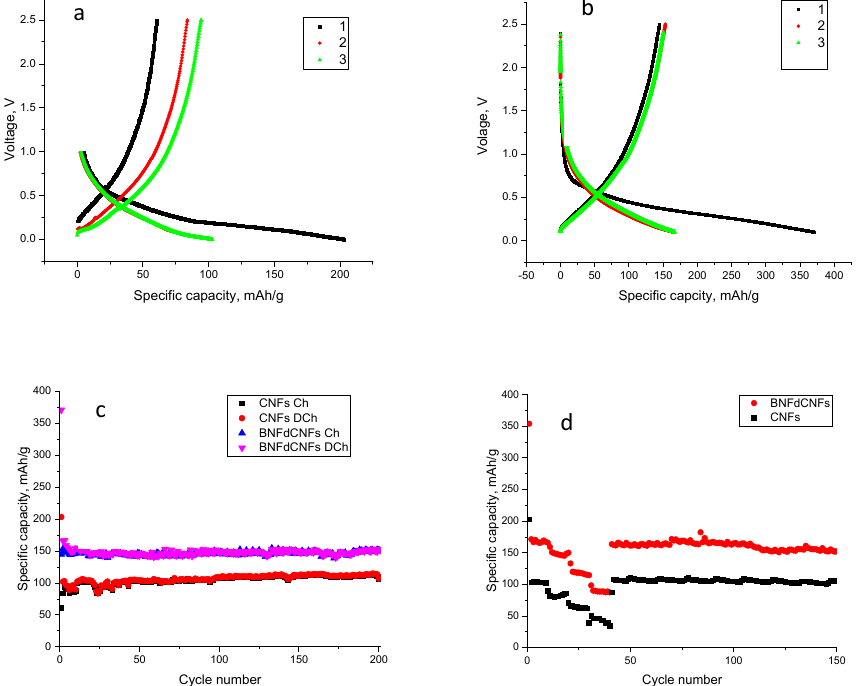
Figure 9. First-cycle discharge charge curves ( a , b ) and cycling ( c ) performance at 100 mA/g, as well as the C rate performance ( d ) of centrifugally spun B, N, F-doped carbon nanofibers at current densities of 100, 200, 400, and 800 mA/g.